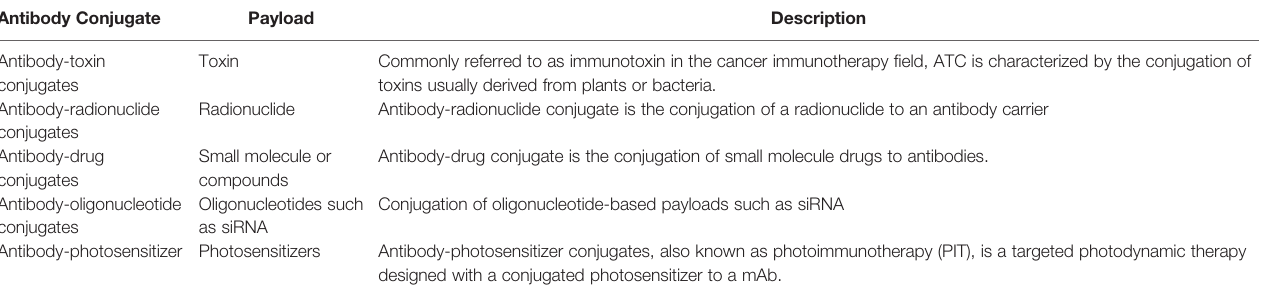
TABLE 1 | Antibody conjugate